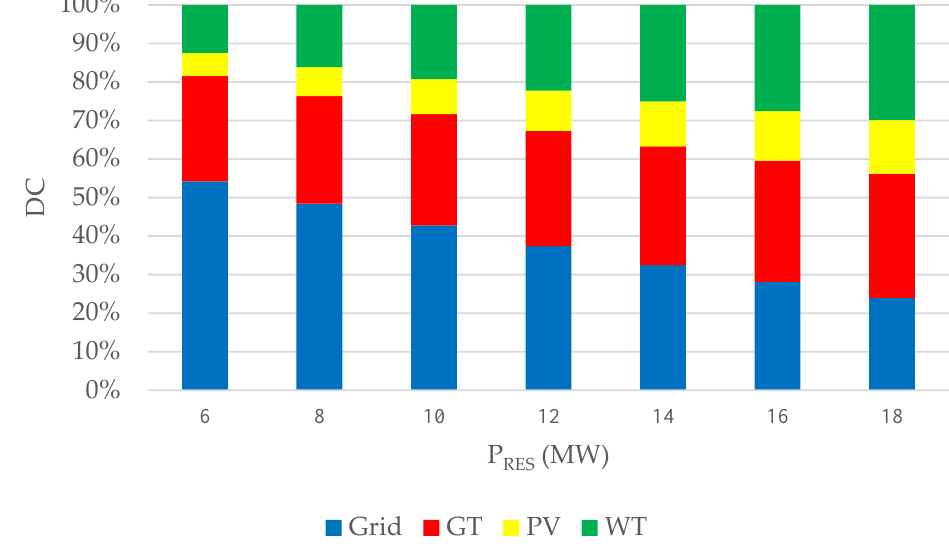
Figure 11. Demand coverage by all electricity sources.